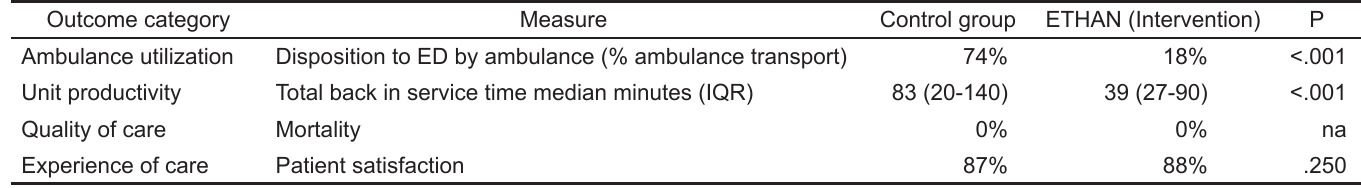
Table 3. Outcome differences comparison in a pilot program that integrates mobile technologies and alternative patient navigation to improve EMS utilization and